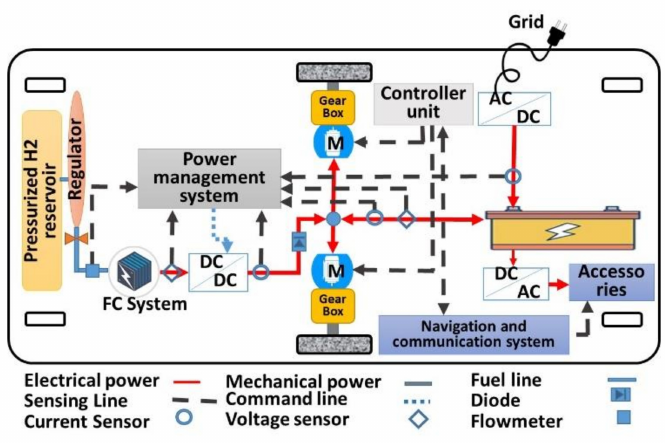
Figure 1. Hybrid self-guided vehicle (SGV) schematic